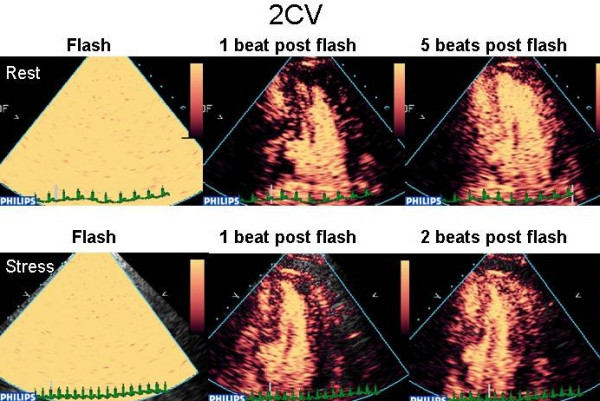
A basal and mid inferior defect is evident 2 beats post flash at peak stress which was not evident at rest, consistent with RCA stenosis. [See additional files 41-46 for movies and 47 and 48 for angiography].